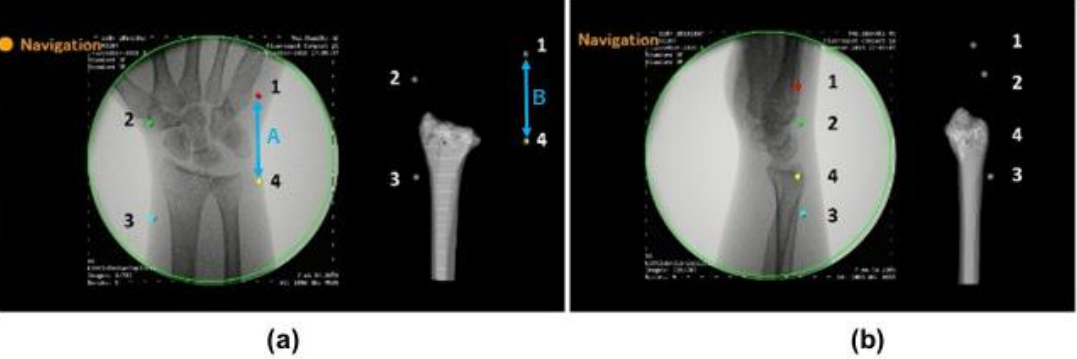
Figure 3. Evaluations of the tracking accuracy. Example images of tracking. ( a ) Posterior-anterior view. ( b ) Ulnar side lateral view. Accuracies were evaluated by comparing the distance between markers on the fluoroscopic image (A) and on the 3D image, which was projected on the monitor (B).